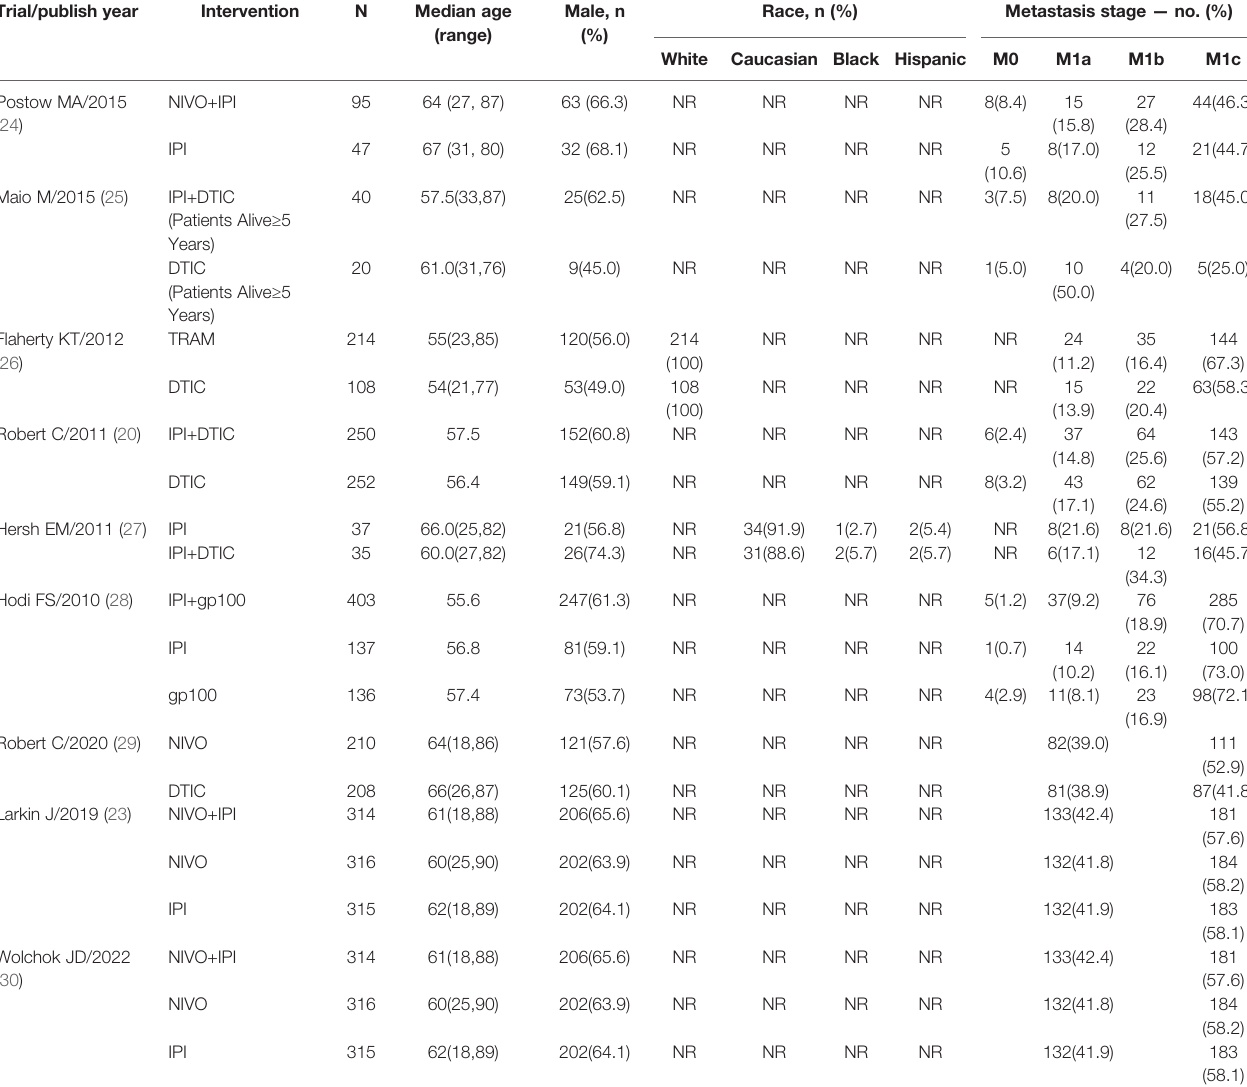
TABLE 2 | Characteristics of patients in randomized controlled trials included in network